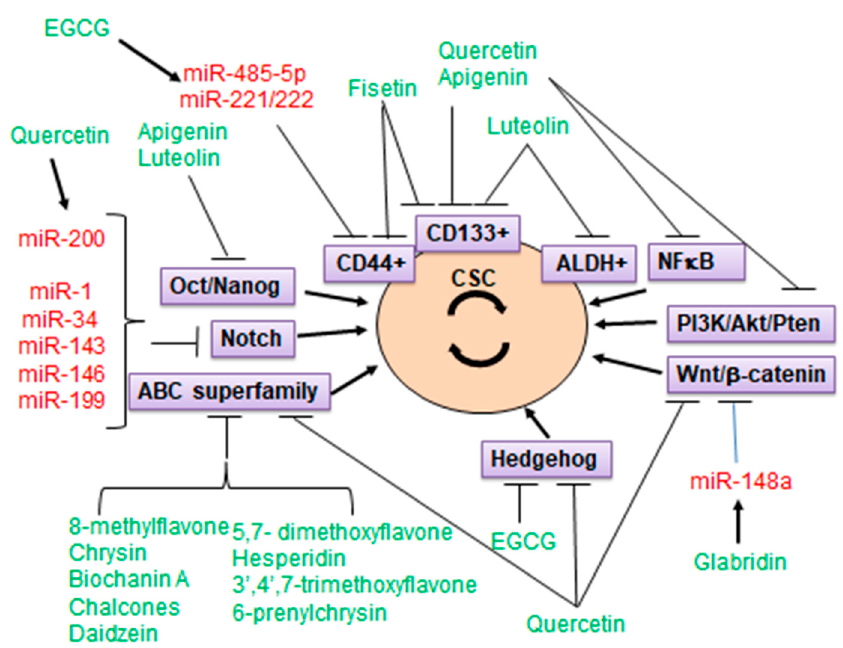
Figure 2. Graphical summary of flavonoids targeting major pathways in CSCs, including those regulated by microRNAs. Major pathways and CSC markers are in purple boxes; flavonoid names are in green; microRNAs are in red.